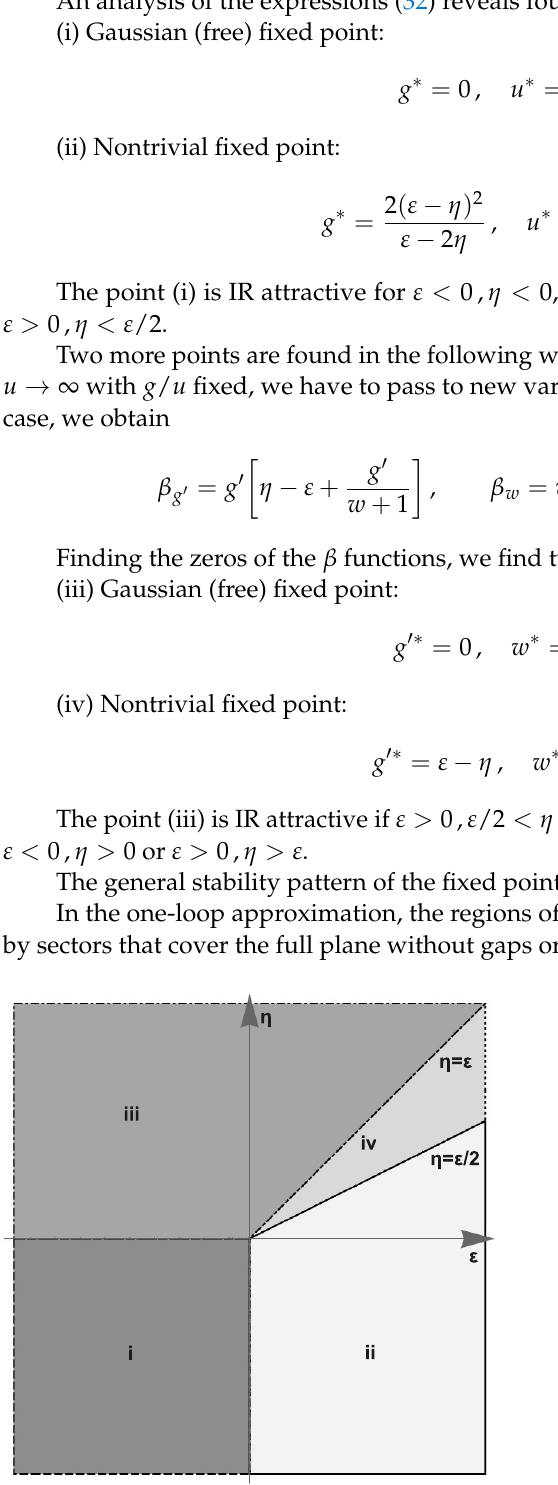
Figure 1. Regions of stability of the fixed points